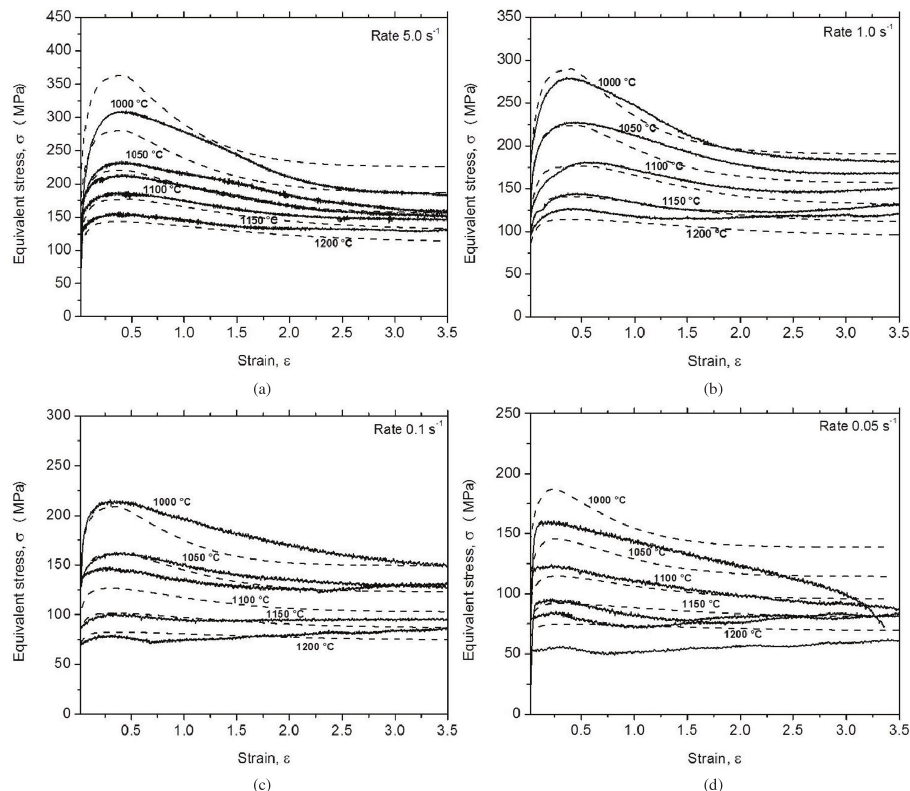
Figure 8. Comparison between experimental flow curves with the molded flow curves for austenitic stainless steel ISO 5832-9: (a) 5.0 s -1 , (b) 1.0 s -1 , (c) 0.1 s -1 (d) 0.05 s -1 .